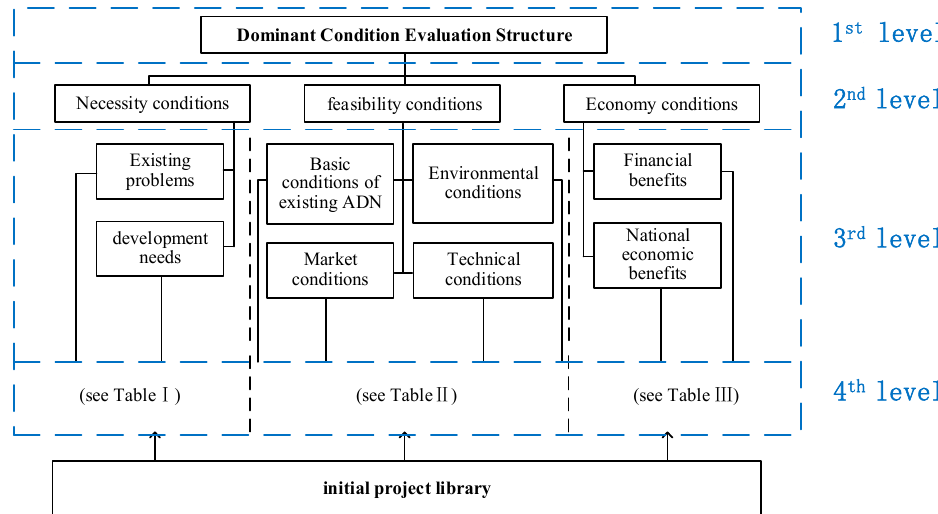
Figure 1. Hierarchical evaluation structure of dominant conditions for individual projects.